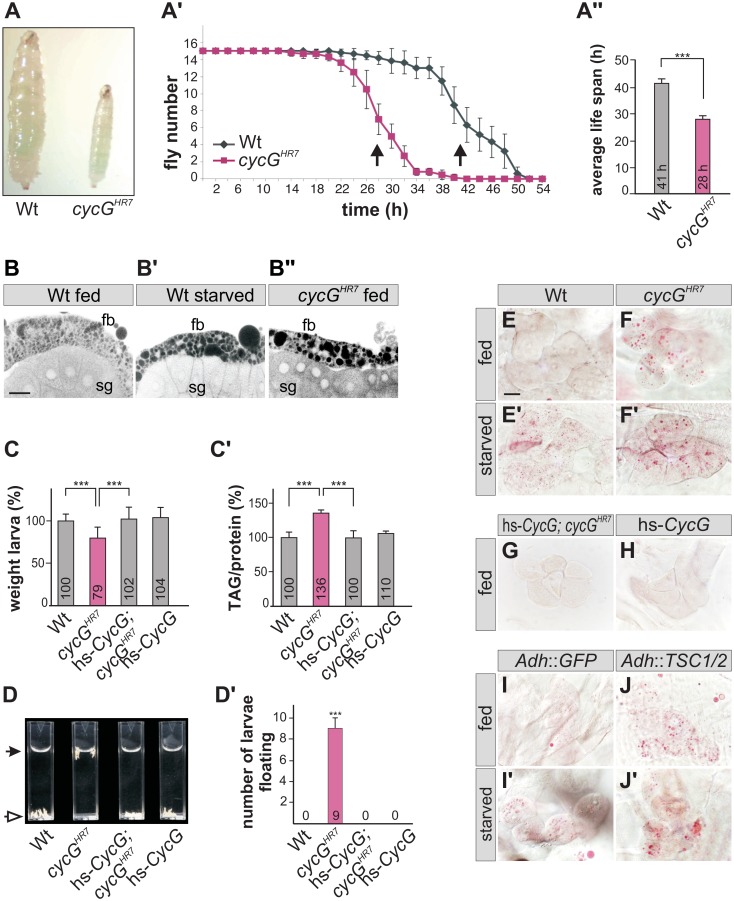

cycG
HR7 mutant animals show defects in fat metabolism.(A) Wild type (Wt) and cycG
HR7 mutants similarly ingest food as visualized by blue colored yeast in the larval gut. (A') Survival rate upon wet starvation was measured in cycG
HR7 mutant males (red) compared to wild type (Wt, black). Sixfold experiment [n = 15]. (A'') The average survival rate for cycG
HR7 is ca 28 hours and for the wild type ca 41 hours, and was taken as the inflexion point of the curve (50% dead animals, arrows in A'). ***p<0.001 according to Student’s T-test. (B-B'') Small lipid droplets are seen in the fat body of a well-fed wild type larva (B, Wt fed). Droplet size increases after of 2 days of amino acid deprivation (B', Wt starved). Similar effects are seen in a well fed cycG
HR7 mutant larva (B'', cycG
HR7 fed). B-B'' represent Nile Red staining of salivary glands (sg) and the adjacent fat body (fb) and were inverted for better visibility. Scale bar: 50 μm. (C) The weight of third instar larvae of the given genotype is depicted in percent of wild type (Wt). Error bars denote standard deviation [n = 100 per genotype]. ***p<0.001 according to Student’s T-test. (C') Histogram depicting TAG content normalized to protein content of the respective larvae shown in C). Wild type levels (Wt) were taken as 100%. Note increase of TAG content in cycG
HR7 mutant larvae by 36% compared to the wild type. Error bars denote standard deviation [n≥3 experiments per genotype]. ***p<0.001 according to Student’s T-test. (D) In contrast to the wild type (Wt, open arrow), cycG
HR7 mutant larvae float (marked with arrow) in the buoyancy test. In a hs-CycG background at ambient temperature, cycG
HR7 mutant larvae subside to the bottom, as also seen for hs-CycG larvae. (D') Statistical evaluation of the buoyancy test repeated five times with 10 larvae each. Error bars denote standard deviation. ***p<0.001 according to Student’s T-test. (E-J') Oil Red O staining was performed on larval pelts to visualize lipid droplet accumulation in oenocytes. Larvae were either well-fed with yeast paste (E-J), or starved for amino acids (E'-J'). For a statistical evaluation see S3 Fig. The following genotypes were tested: (E-E') wild type (Wt). (F-F') cycG
HR7 homozygotes. (G) hs-CycG; cycG
HR7 (ambient temperature). (H) hs-CycG (ambient temperature). (I-J') Overexpression of a control (UAS-GFP) or of TSC1/2 specifically in the larval fat body. (I-I') Adh-Gal4/+; UAS-GFP/+ (Adh::GFP). (J-J') Adh-Gal4/+; UAS-TSC1 UAS-TSC2 (Adh::TSC1/2). Scale bar: 20 μm.